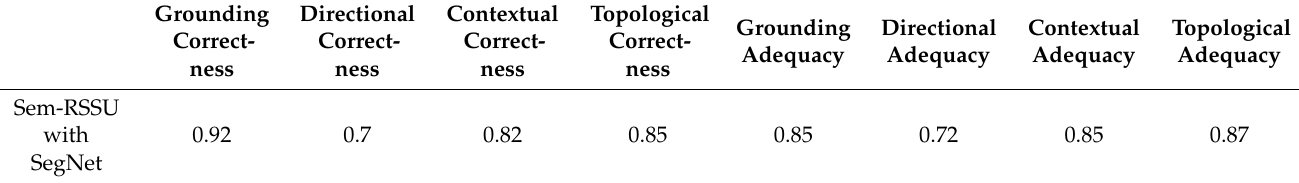
Table 4. Human Evaluation metrics for grounded natural language scene description rendering. Grounding